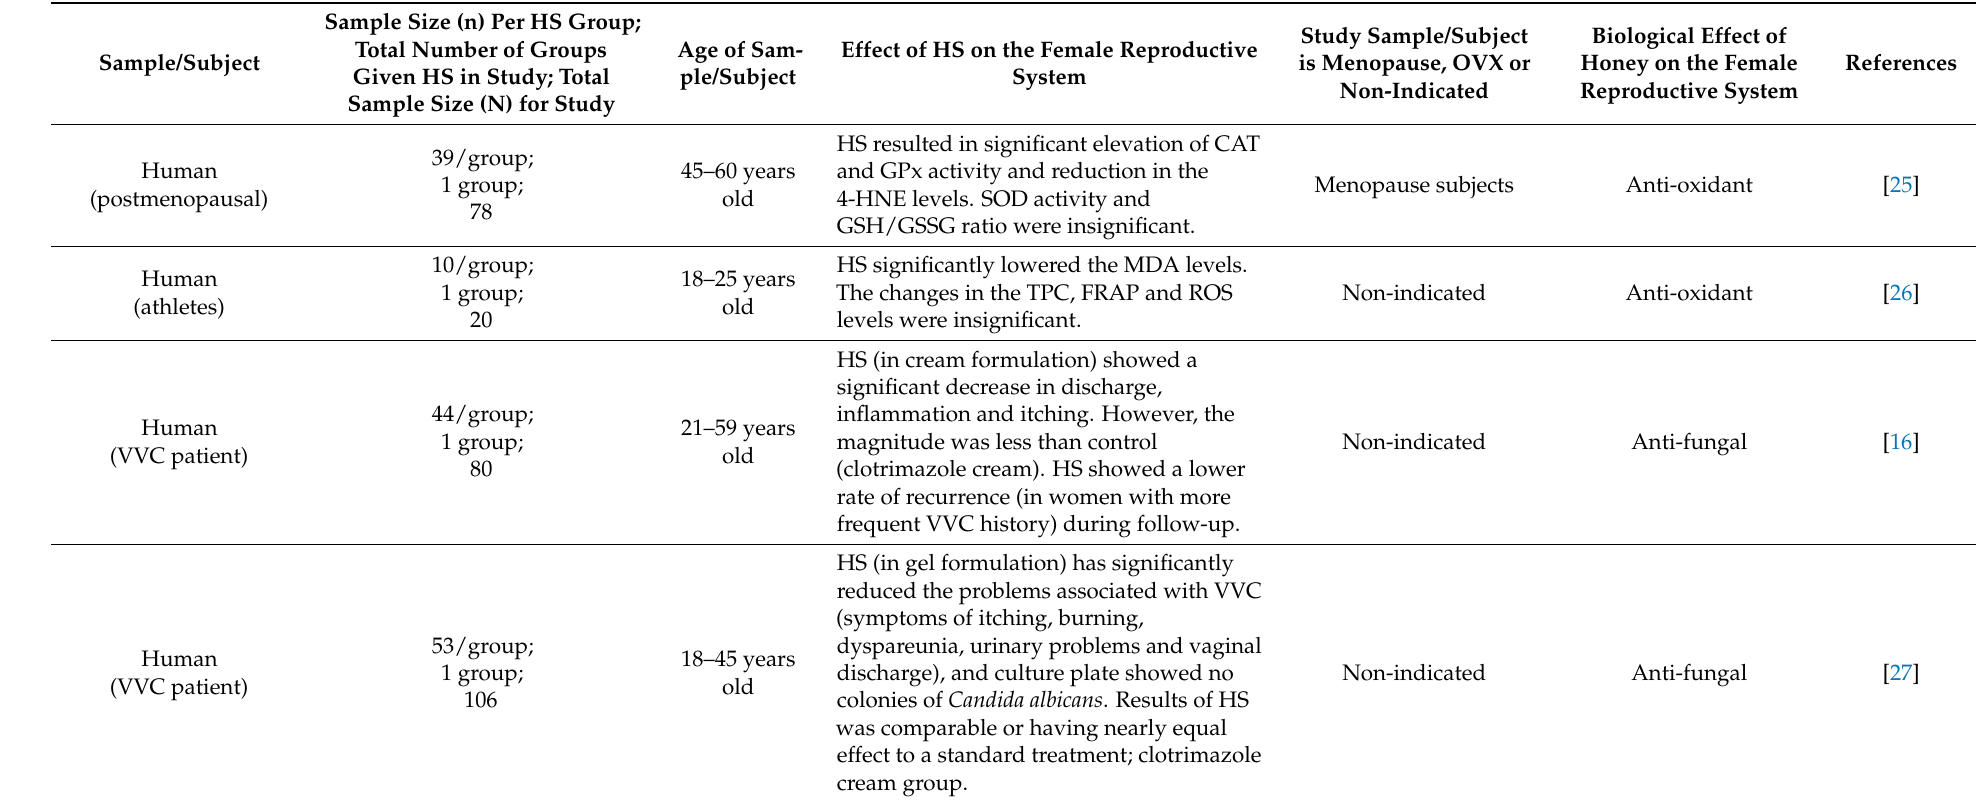
Table 3. Effect of honey supplementation on the female reproductive system in human